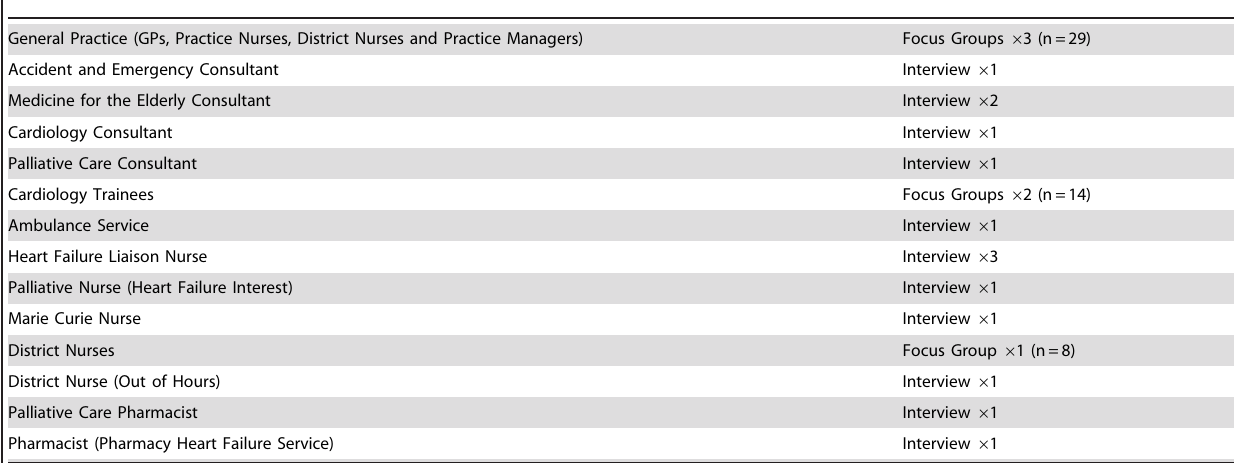
Table 3. Health Professional